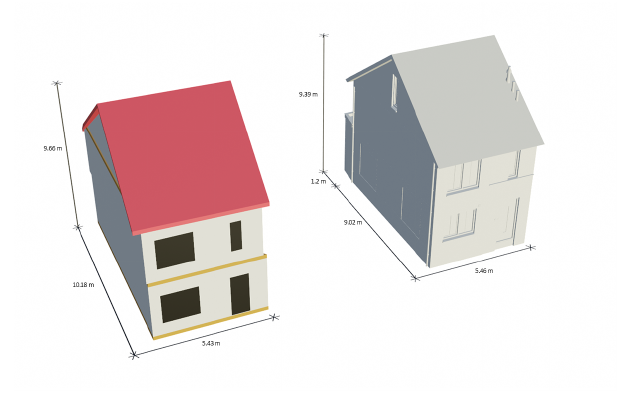
Figure 5. Visual results (in Blender) for BAG ID